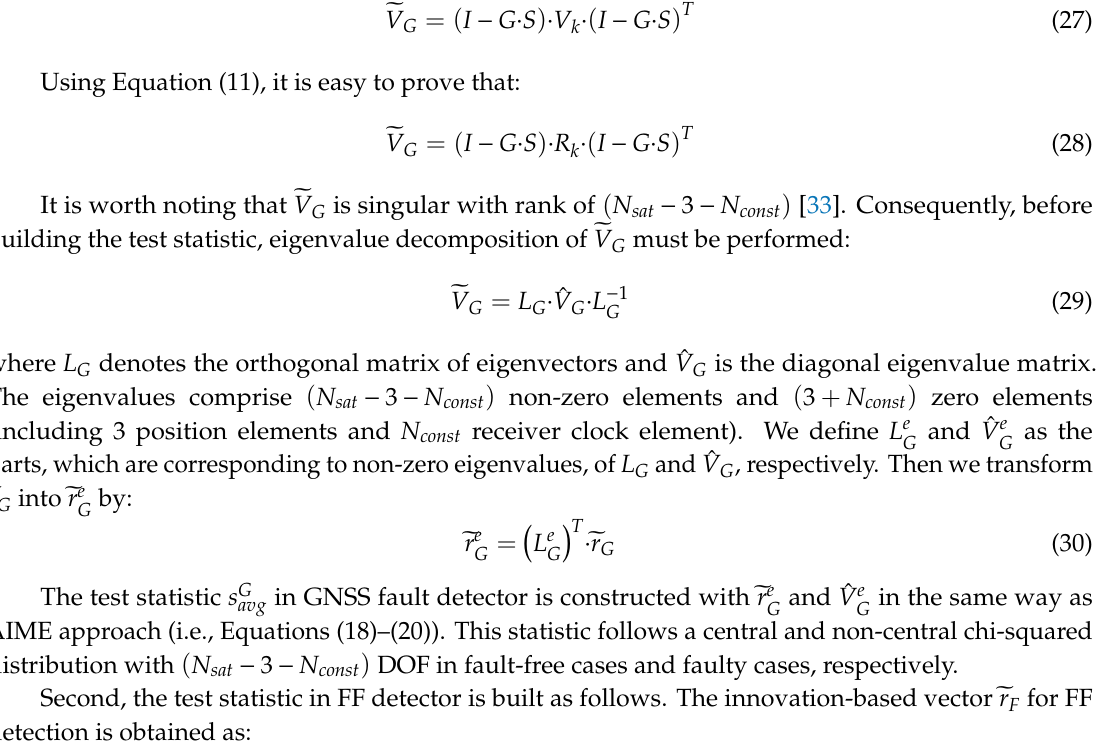
... Figure 4. An example of various subsets ( 𝑁 (cid:3046)(cid:3028)(cid:3047) = 6 ). To avoid calculating the statistics for all the subsets, we pre-set the probability 𝑃 (cid:3036)(cid:3034)(cid:3041)(cid:3042)(cid:3045)(cid:3032)(cid:3031) accounting for unconsidered fault modes to filter out the subsets with low probabilities. Then the maximum number 𝑁 (cid:3040)(cid:3028)(cid:3051) of simultaneous faults that need to be considered is determined based on the prior fault probability of each subset. The method to determine 𝑁 (cid:3040)(cid:3028)(cid:3051) and the monitored subsets is provided in ARAIM baseline algorithm description [9]. For each subset determined above, the statistic is constructed based on the corresponding hypothesis. For subset 𝑗 , a new innovation-based vector is given as: 𝑟̃ (cid:3008) ((cid:3037)) = (cid:3435)𝐼 − 𝐺 ∙ 𝑆 ((cid:3037)) (cid:3439) ∙ 𝑟 (cid:3038)